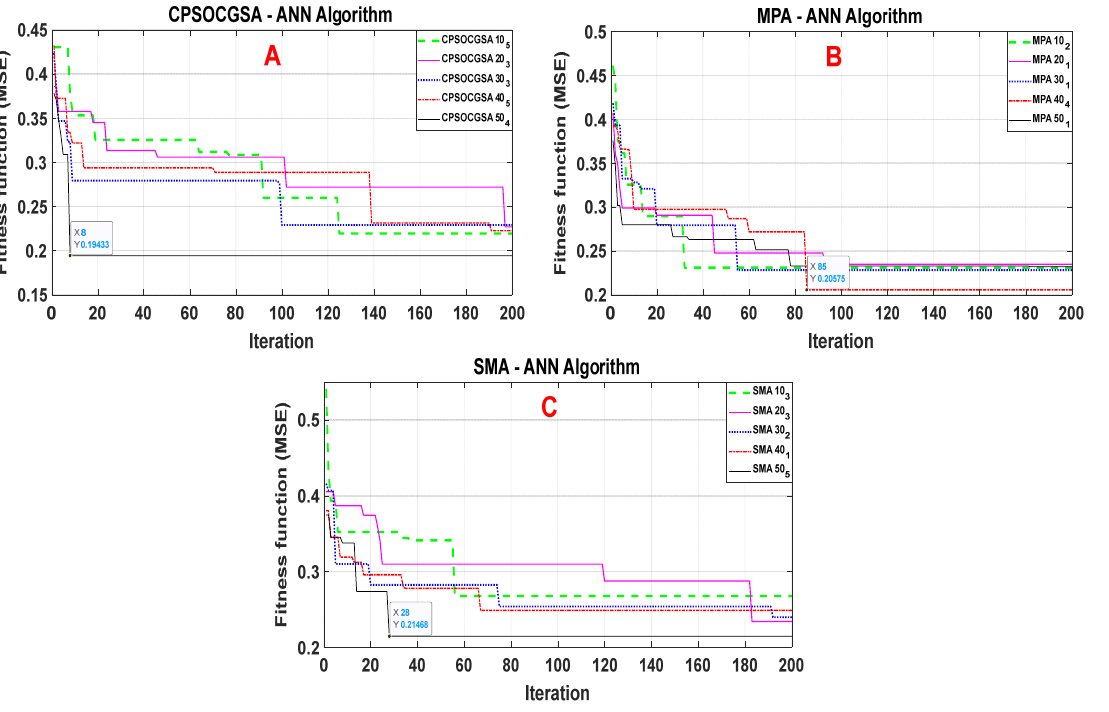
Figure 8. Performance of the CPSOCGSA-ANN, MPA-ANN, and SMA-ANN algorithms for SPI 6. Table 4. ANN parameters are based on algorithms for SPI 1, SPI 3, and SPI 6. Table 4. ANN parameters are based on algorithms for SPI 1, SPI 3, and SPI 6.